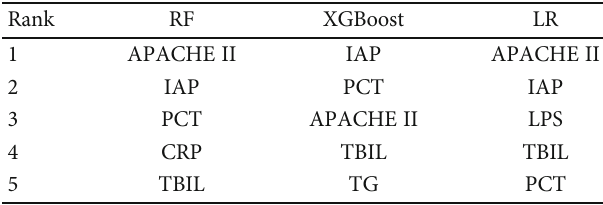
Figure 2: The receiver operating characteristic (ROC) curves of 5 di ff erent models in predicting AKI in AP patients after admission in the test dataset. Abbreviations: XGBoost: extreme gradient boosting; RF: random forest; SVM: support vector machine; LR: logistic regression; CART: classi fi cation and regression tree. Table 3: The detailed performance metrics for the 5 models. Table 4: The ranks of feature importance in XGBoost, RF, and LR for predicting LR